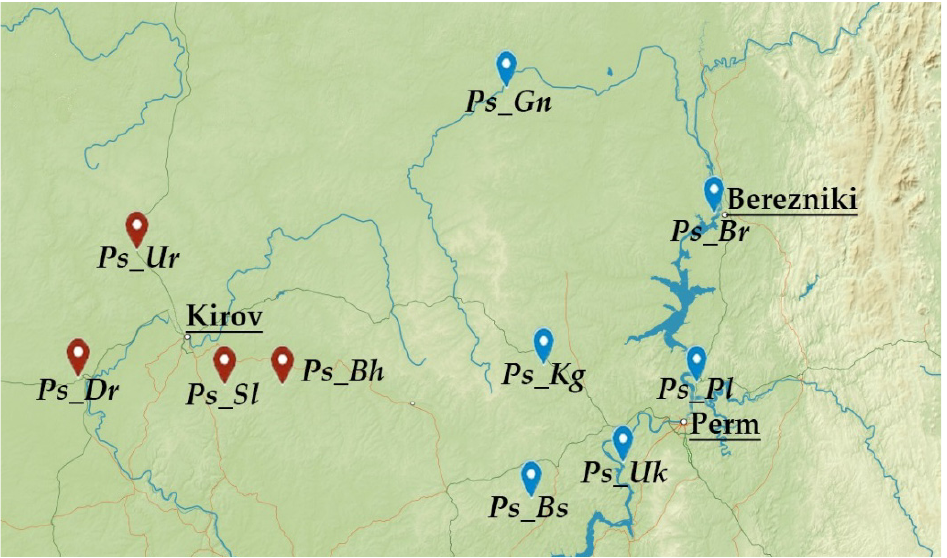
Figure 1. Schematic map of the location of the studied populations of P. sylvestris